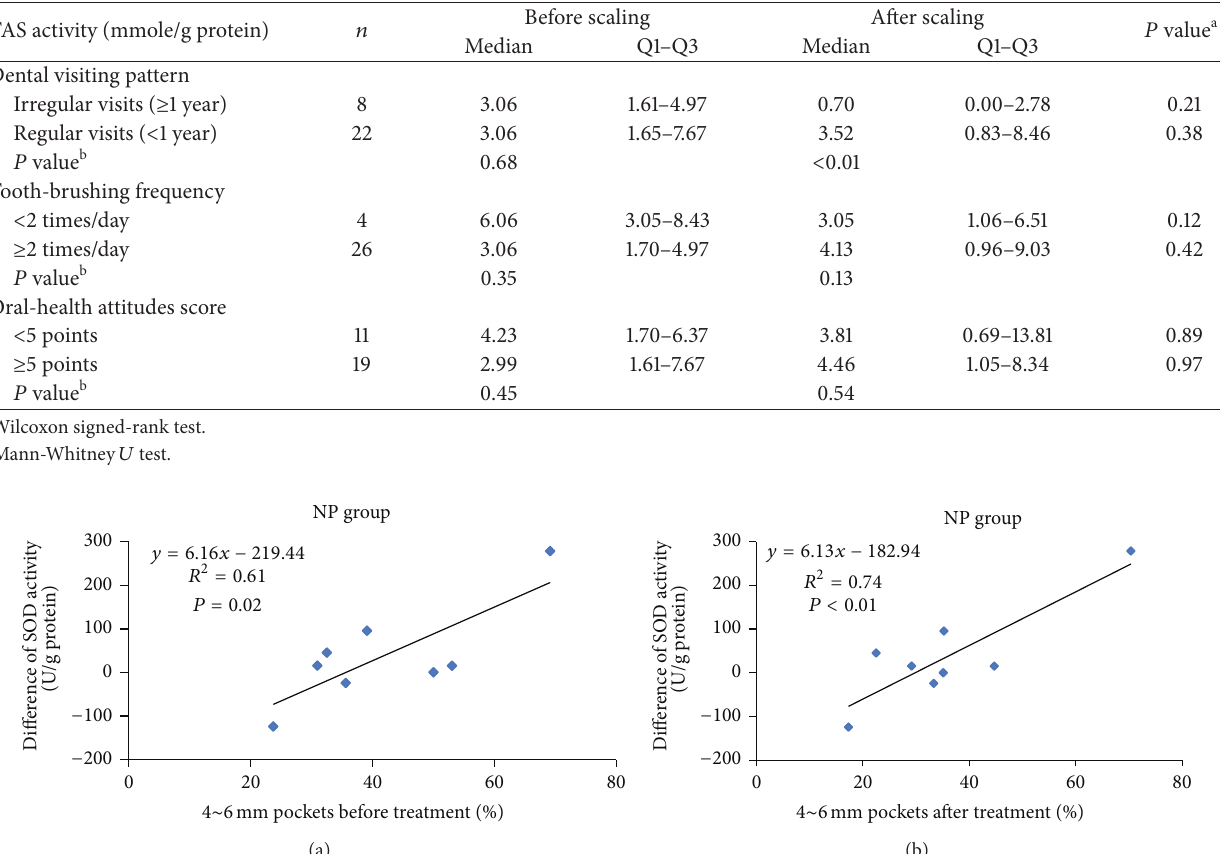
Table 3: Comparison of the total antioxidant capacity (TAOC) between oral-health behavior and attitude strata.